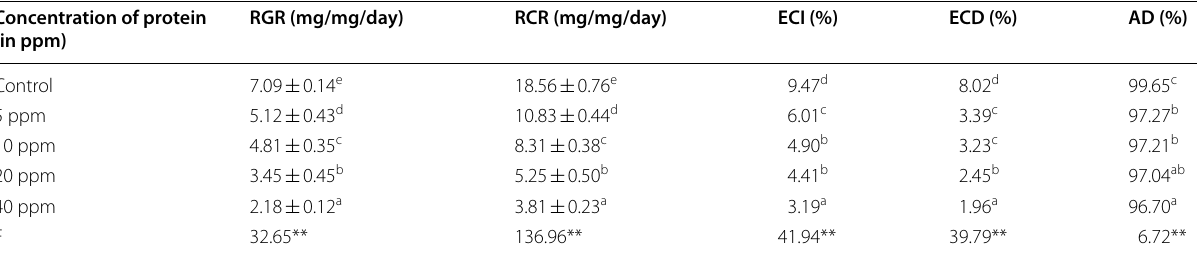
Table 5 Effect of chitinolytic protein extracts of Alternaria alternata VLH1 on nutritional physiology of third instar larvae of Helicoverpa armigera (96 HAT)